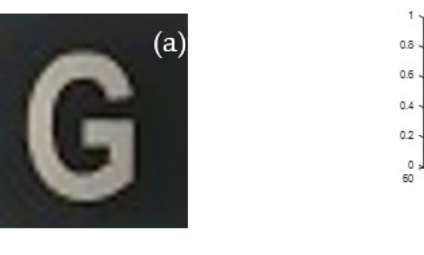
Figure 12. Test image: ( a ) original image and ( b ) the three-dimensional surface of the original image.